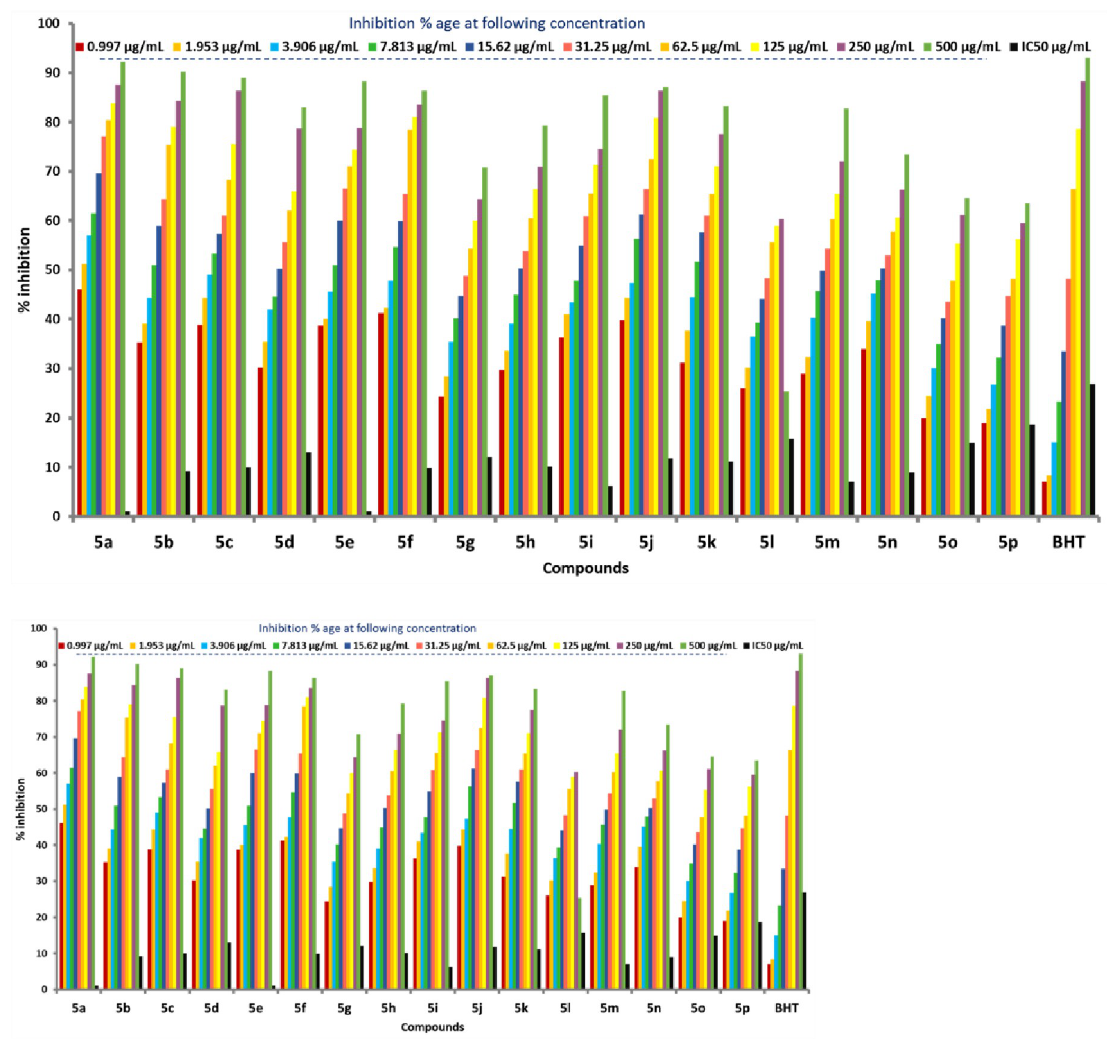
Fig 1. Antioxidant activity of compounds